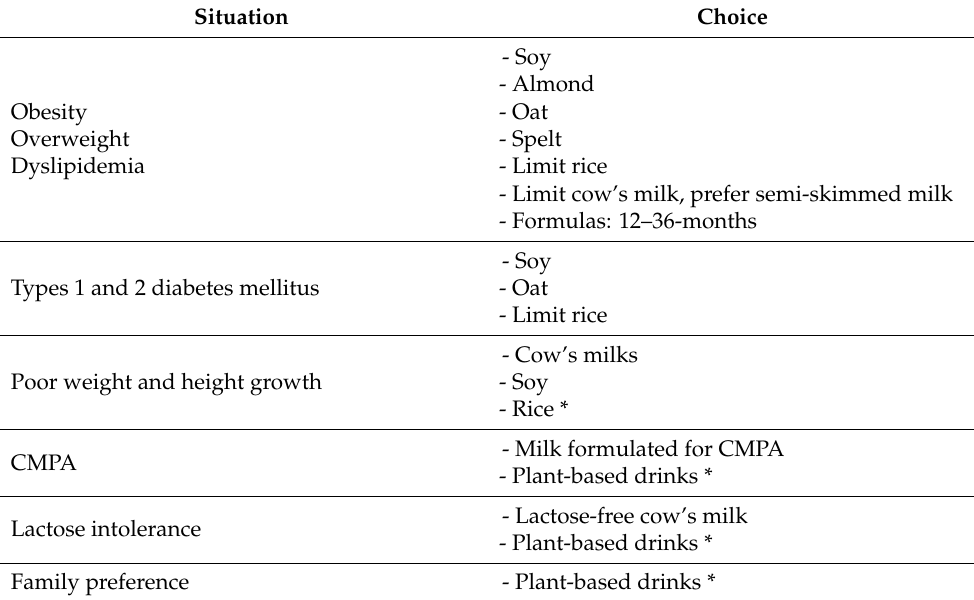
Table 4. Suggestions for the use of plant-based milk alternatives in specific situations starting